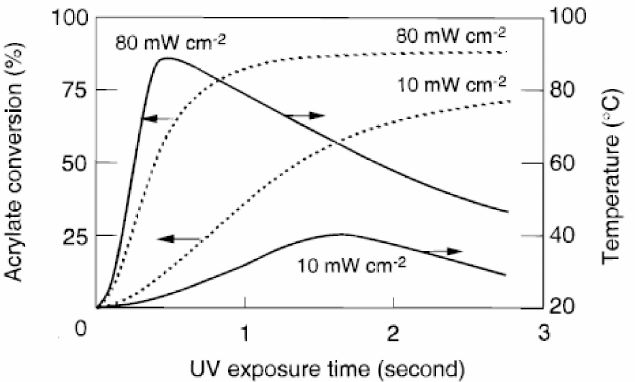
Figure 2. Temperature profile vs. exposure time (solid line) and conversion profile vs. exposure time (dashed line) for different UV light intensities of photopolymerization of polyurethane-acrylates. Reprinted with permission of John Wiley and Sons from reference